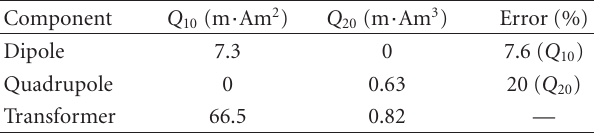
Table 1: Components of the multipole